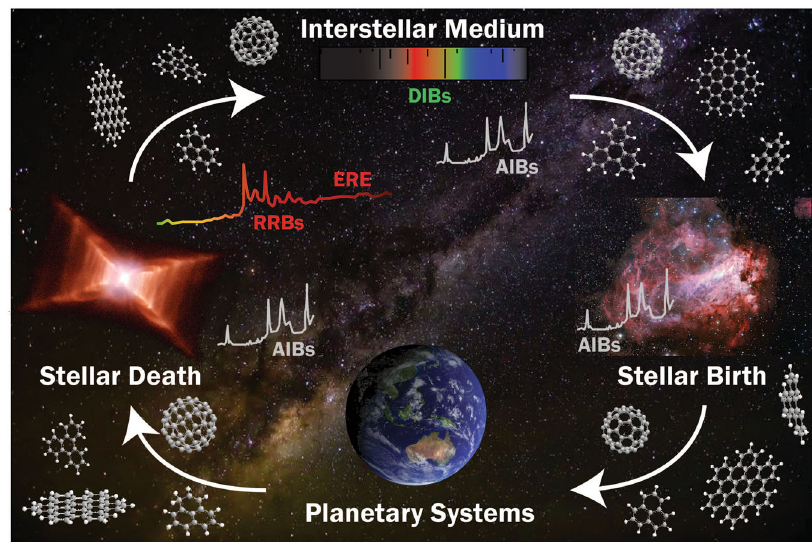
Fig. 1 The life-cycle of carbon and associated spectroscopic features. Carbon is cycled between planetary systems and the interstellar medium as stars die and are reborn. Along the way carbon-based molecules exhibit many spectroscopic phenomena posing unanswered questions. AIBs aromatic infrared bands, RRBs Red Rectangle bands, ERE extended red emission, DIBs diffuse interstellar bands. [Red Rectangle Image (left): NASA; ESA; Hans Van Winckel (Catholic University of Leuven, Belgium); and Martin Cohen (University of California, Berkeley). Messer 17 Image (right): European Southern Observatory. Image of Earth (bottom): NASA. Image of Milky Way (dark emu, background): Rowen